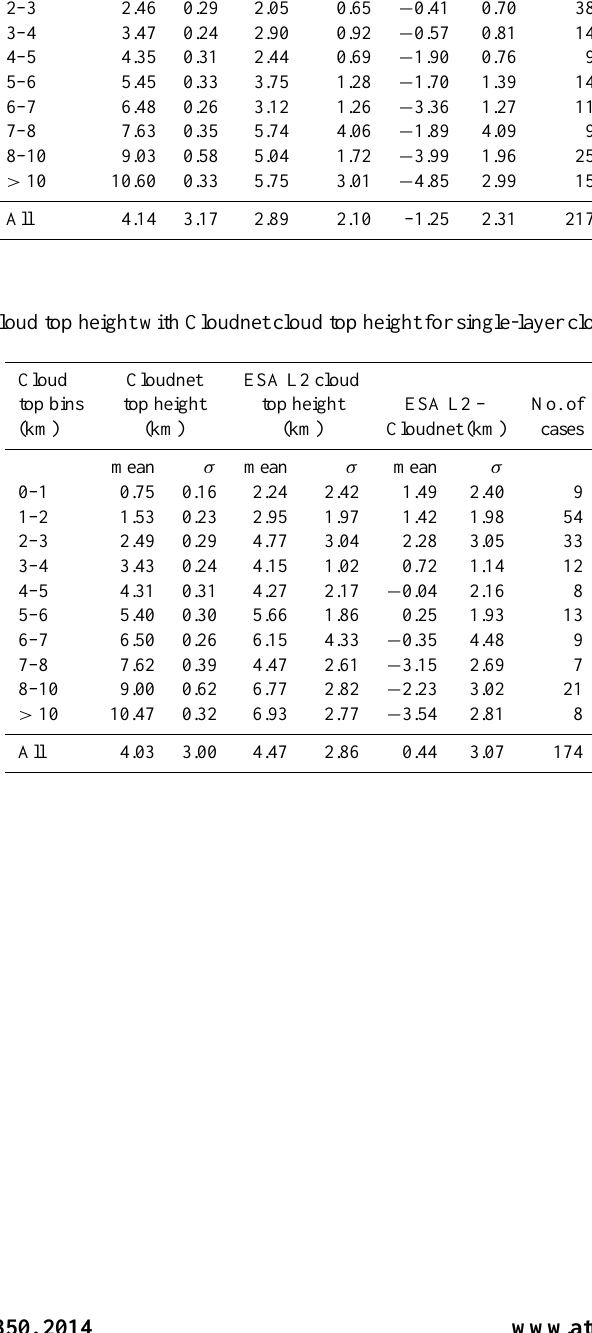
Table A1. Comparison of SCIAMACHY FRESCO cloud height with Cloudnet cloud top height for single-layer clouds. Cloud Cloudnet top cloud top FRESCO cloud FRESCO – No. of bins (km) height (km) height (km) Cloudnet (km) cases mean σ mean σ mean σ 0–1 0.79